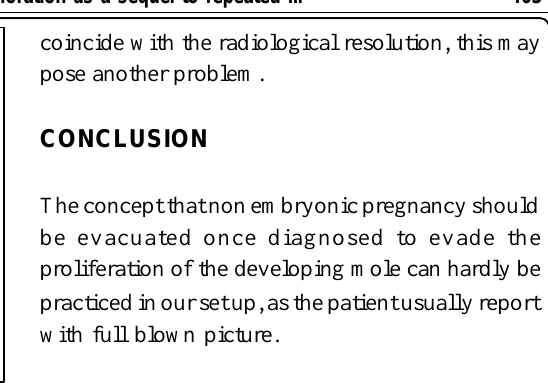
Fig. 5 : CT Scan, which clearly defines the